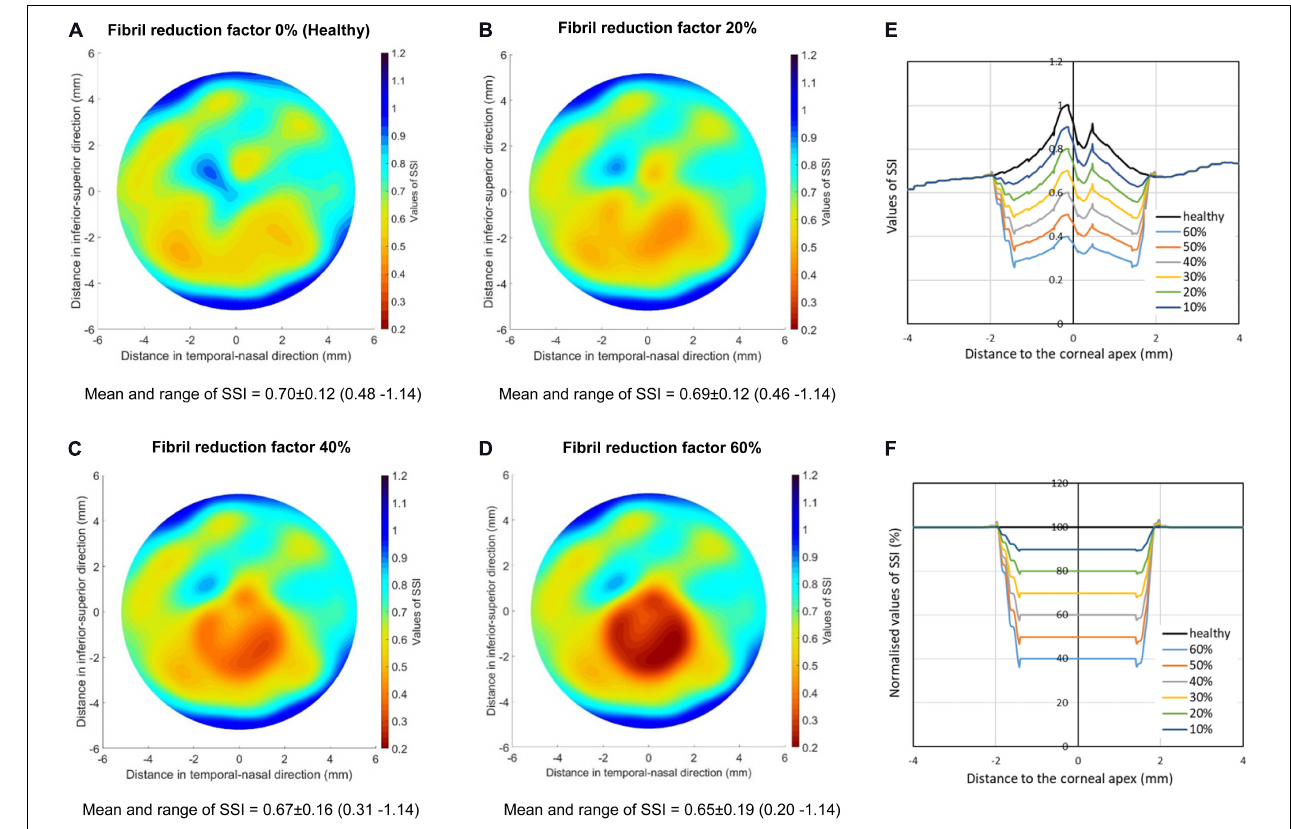
FIGURE 5 | SSI maps for KC corneas with cones experiencing fibril reductions of 0 (A) , 20% (B) , 40% (C) , and 60% (D) . The cones had 2.0 mm radius and were located on the vertical central meridian of the cornea. In all cases, the cones’ centers were at 1.0 mm away from corneal apex. The values of SSI provided for each case represented the mean ± standard deviation and range from minimum to maximum value. (E,F) depict the SSI values along the horizontal central meridian of the cornea before (E) and after (F) normalization relative to the corresponding SSI values of the healthy